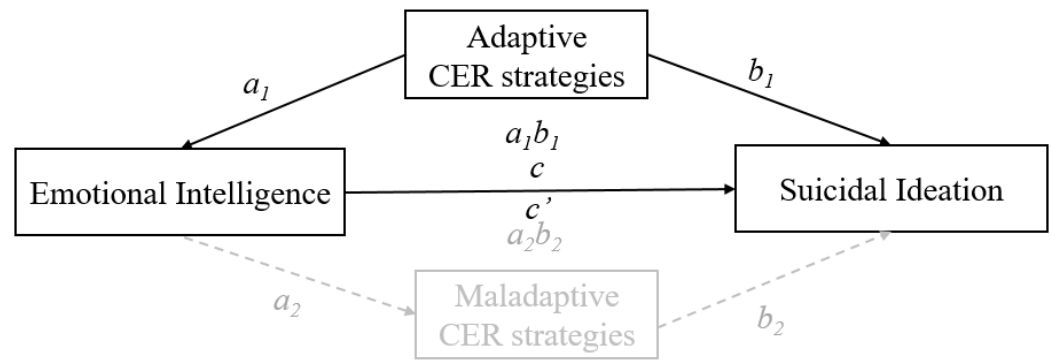
Figure 2. Illustration of the final mediation model: The mediating role of adaptive cognitive emotion regulation strategies in the relationship between EI and suicidal ideation.